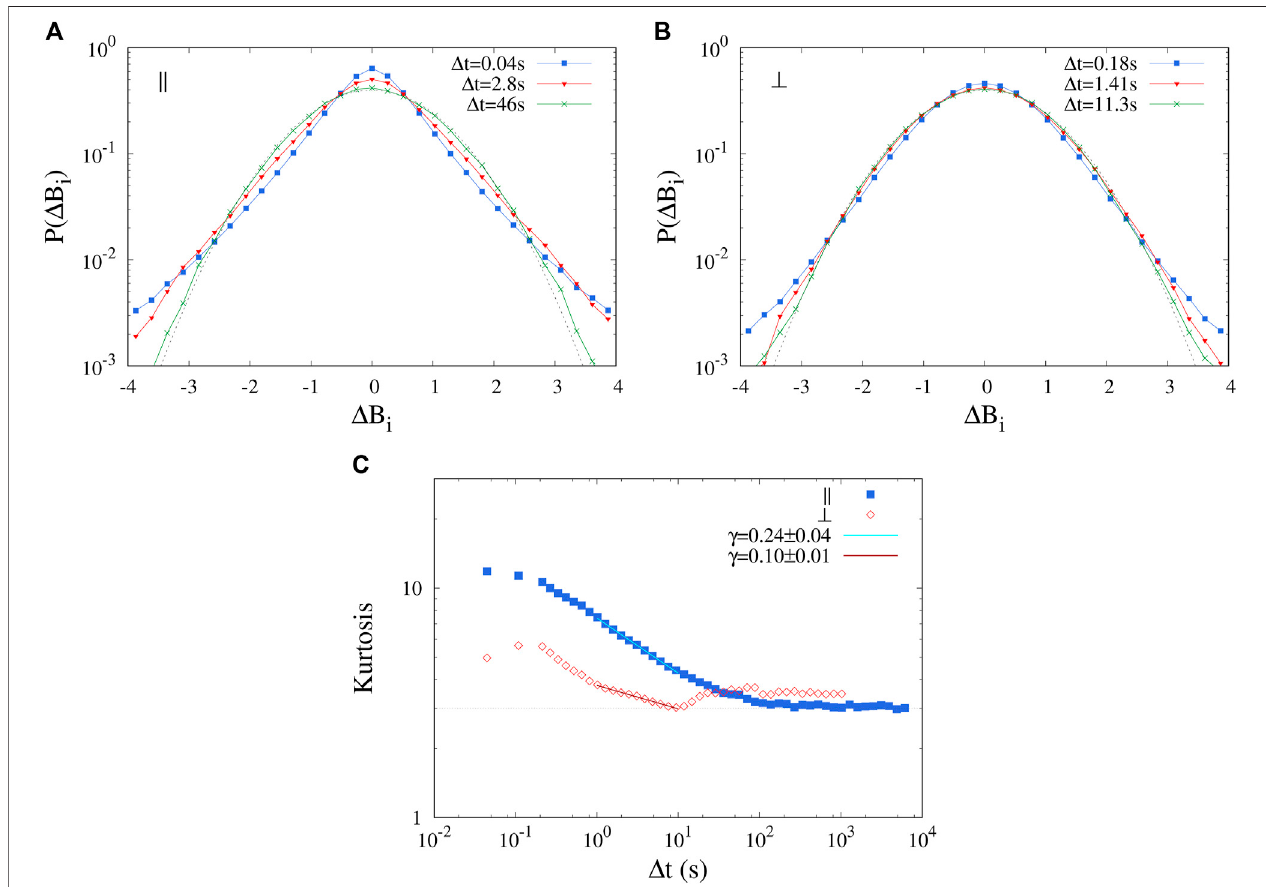
FIGURE 3 | (A,B) : scale-dependent PDFs of the magnetic fi eld fl uctuations, averaged over the four spacecraft and three components, and shown here at three differenttimelags.Gaussianreferencecurvesareindicatedasdashedlines. (A) :quasi-parallelinterval( (cid:3) ); (B) :quasiperpendicularinterval( ⊥ ). (C) :kurtosis K ofthescale- dependentmagnetic fi eld fl uctuations,averagedoverthethreecomponentsandfoursatellites,forbothintervals[quasi-parallel, (cid:3) andquasi-perpendicular,( ⊥ )].Apower- law fi t K ∝ Δ t − γ in the larger-scale range is indicated for both samples, and the scaling exponents γ are listed.